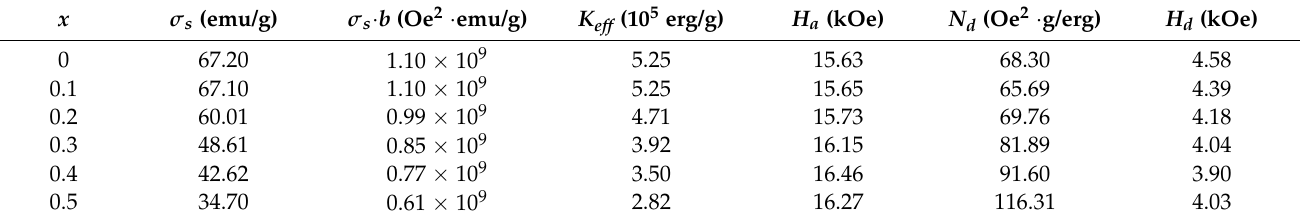
Table 5. Calculated values σ s , K eff , H a , N d , and H d for SrFe 12-x Nd x O 19 (0 ≤ x ≤ 0.5)